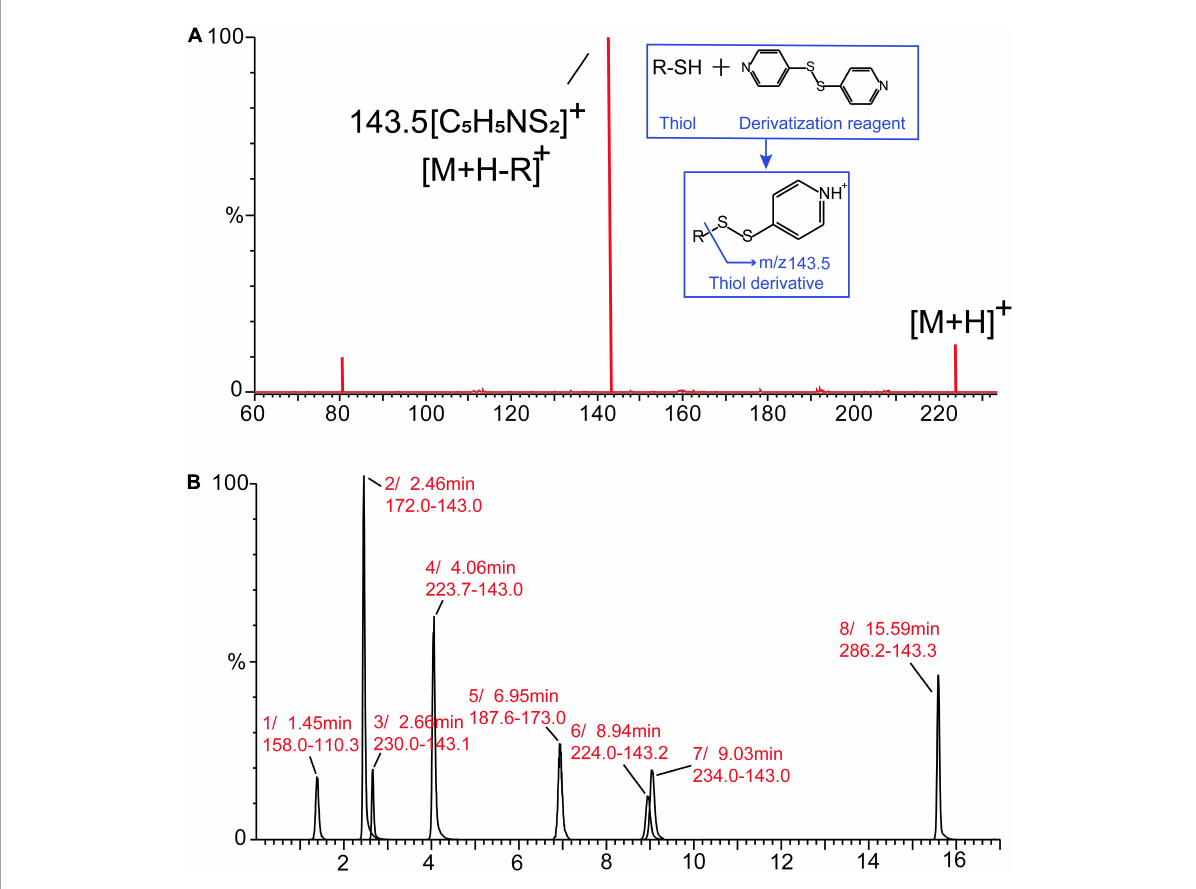
FIGURE1 Mass spectrometry (MS/MS) spectrum of the derivatized thiols (A) . Multiple-reaction-monitoring (MRM) analysis of the derivatized thiol standards (1–8) in positive mode by ultraperformance liquid chromatography (UPLC)–mass spectrometry (MS/MS) (B)